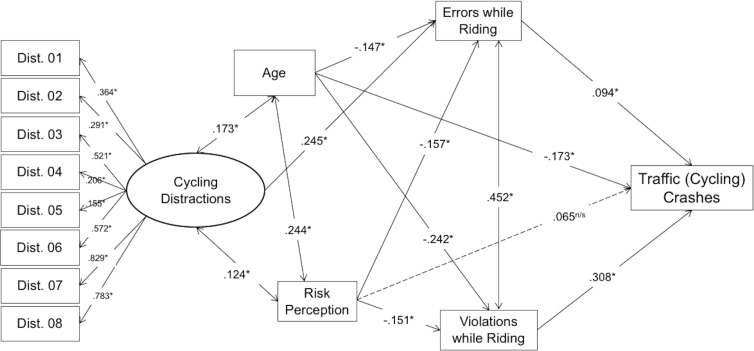
Structural equation model for predicting traffic crash rates.The directions and significances of the variables contained in the path (SEM) analysis. Both cycling errors and violations mediate the predictive role of distractions on traffic crash rates.